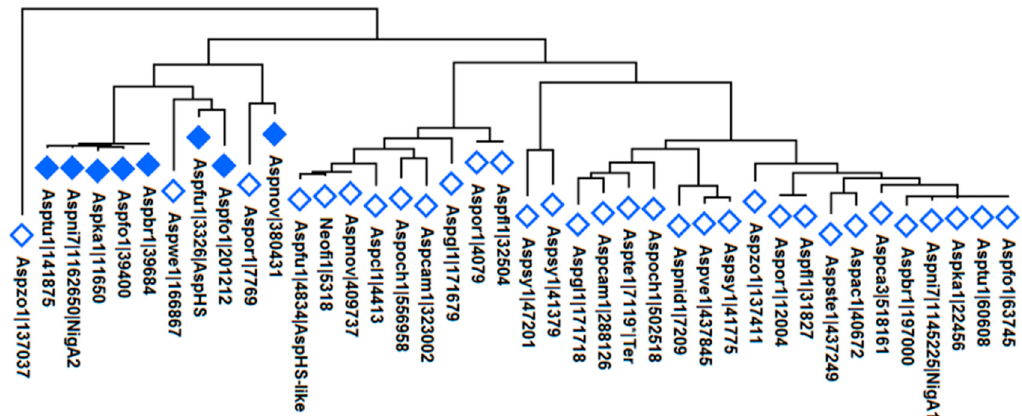
Figure 10. Phylogenetic analysis of aegerolysins in Aspergillus species. Evolutionary analysis including 40 aegerolysin protein sequences was inferred using MEGAX [52], Aspfl1|27858* and Aspfl1|29773* were omitted due to conflicting annotation data. Molecular phylogenetic analysis was performed using the maximum likelihood method and JTT matrix-based model [51] after ClustalW alignment. All positions containing gaps and missing data were eliminated. There were 210 positions in the final dataset. *, sequence from different resources may vary; closed diamonds, aegerolysin with syntenic MACPF-like proteins.